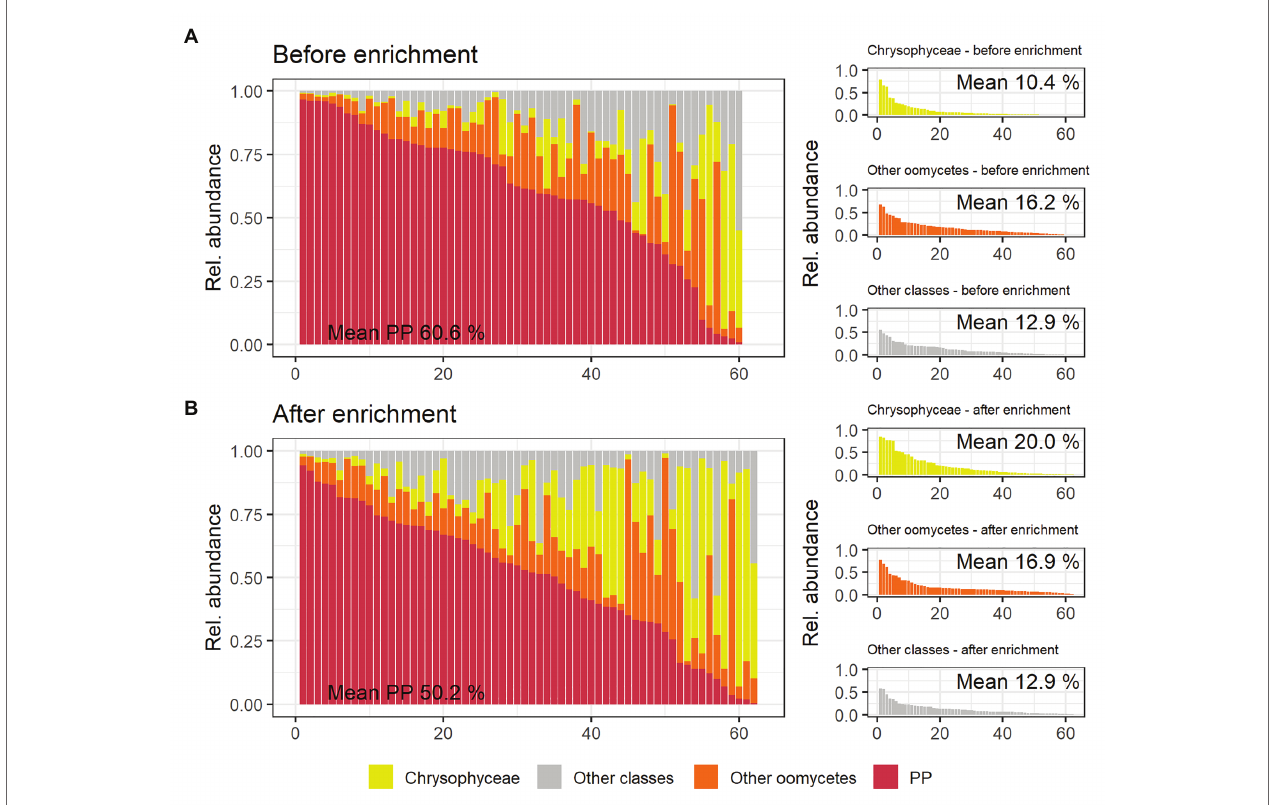
FIGURE 3 | Overview of taxonomic classes of interest and their relative abundance per rhizospheric soil sample detected by metabarcoding using the oomycete ITS1 marker. (A) shows the relative abundances in soil samples before enrichment, (B) shows corresponding results in soil after enrichment. The large panels show relative abundances of plant pathogenic oomycete genera (PP, red) per sample ranked from the sample with the highest to the lowest relative abundance. The relative abundances of other Oomycetes, Chrysophyceae, and all other classes (including not taxonomically assigned ASVs) are shown in orange, yellow, and gray, respectively. These groups are also shown as separate, smaller graphs in the right panels of (A) and (B) , with the mean percentages of reads belonging to the different taxonomic classes given in each panel.